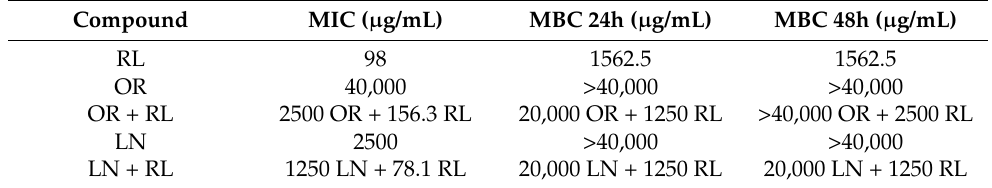
Table 2. Antimicrobial activity of the tested compounds against B. cereus vegetative